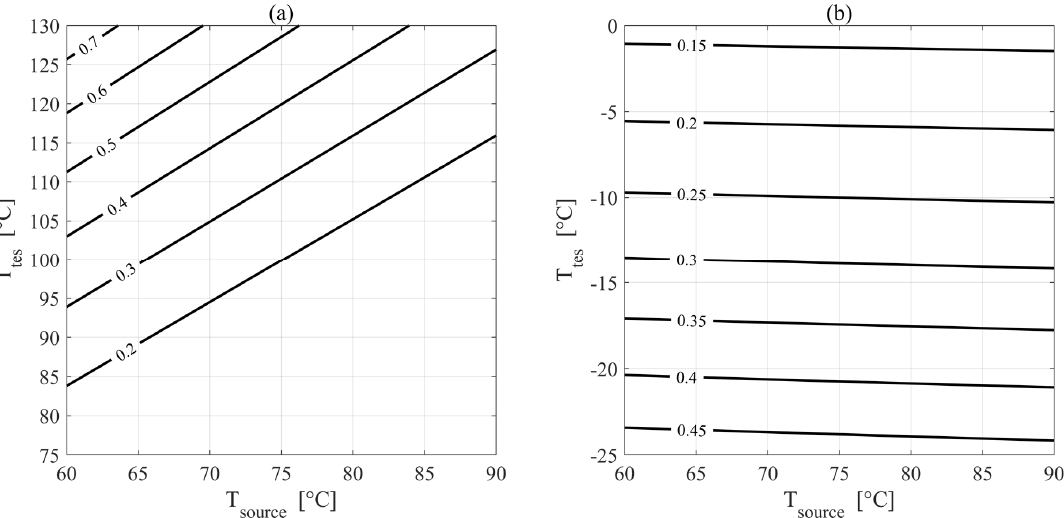
. . W ch / Q source in terms of heat source temperature